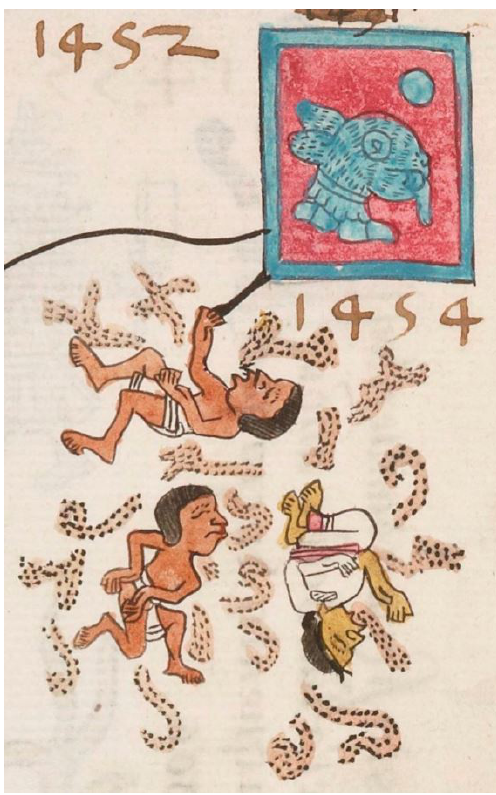
Figure 3. Expression of dust storms and people who succumbed to famine, from the Codex Telleriano-Remensis (AS3), folio 32v(erso), portraying the famine of the year of the One Rabbit in 1454 (year sign for One Rabbit, top right). According to Therrell et al. (2004), the famine resulted from a multi-year drought, possibly coupled with an early autumn frost in